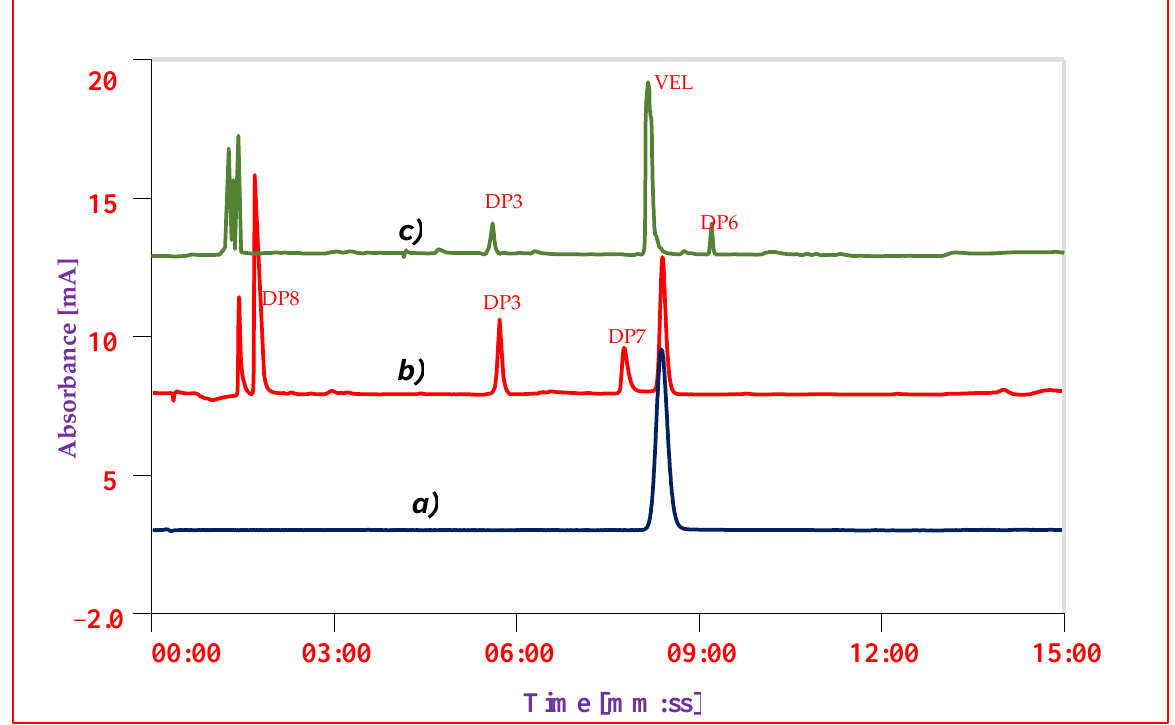
Figure 6. Chromatograms of VEL-CSD ( a ) Reference standard of VEL, ( b ) Hydrolysis in acidic condition ( c ) Hydrolysis in alkaline condition.